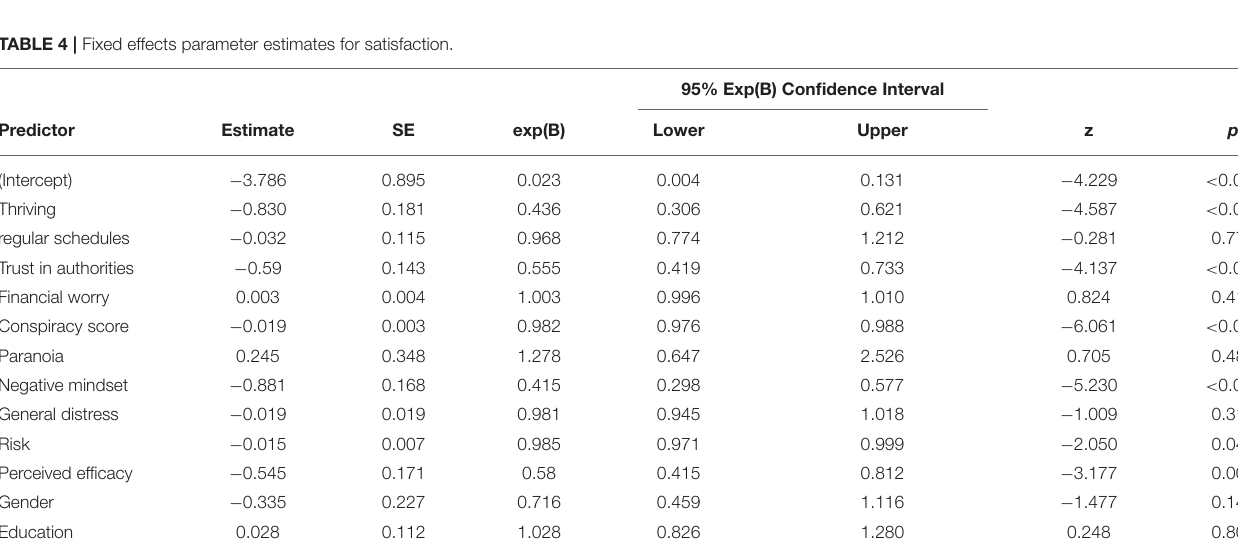
FIGURE 4 | Estimates for paranoia per country, April data.